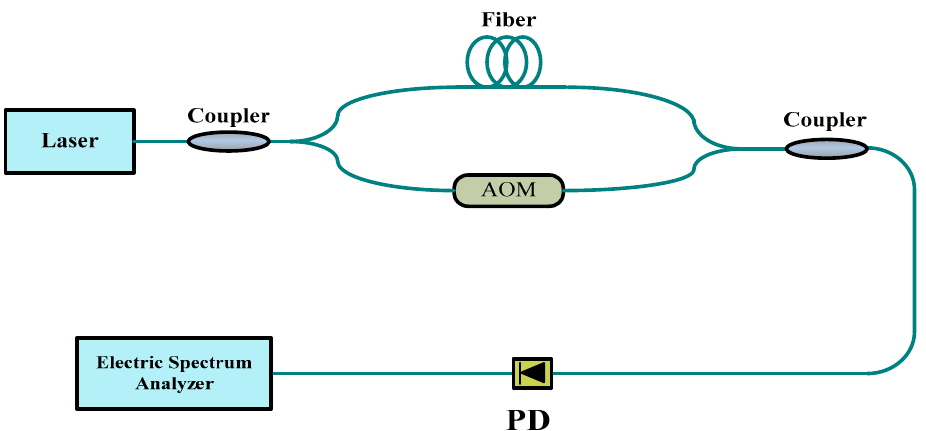
Figure 1. Schematic diagram of the experimental setup for the Er 3+ :Yb 3+ -co-doped fiber amplifier (EYDFA) system.